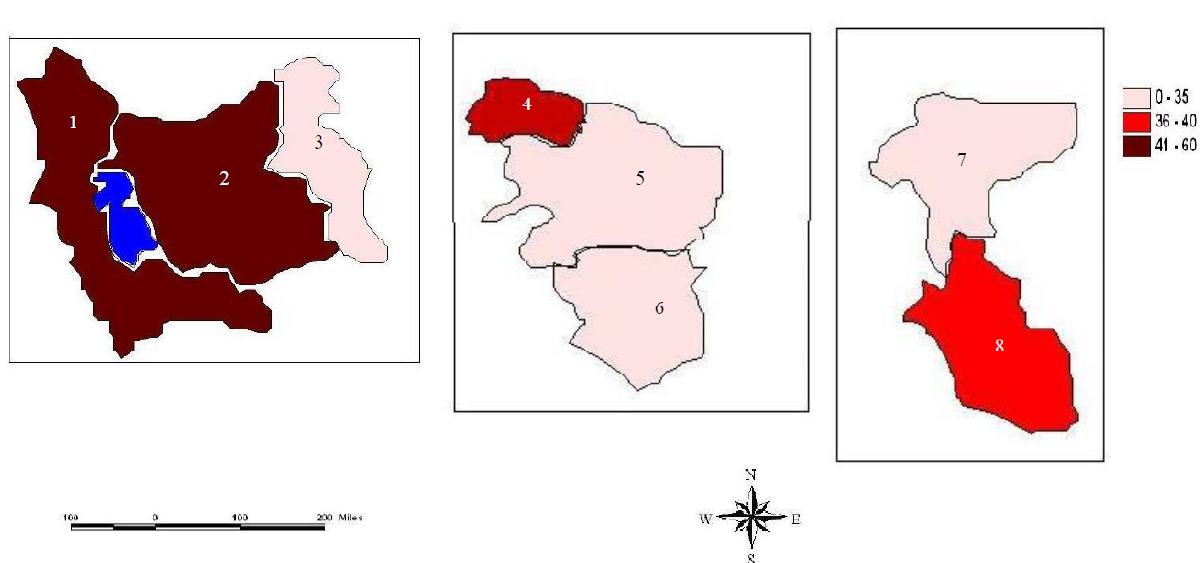
Fig. 5. Location rating based on all climate variables. 1-West Azerbaijan; 2-East Azerbaijan; 3-Ardabil; 4-north of Khorasan; 5-Raza- vi Khorasan; 6-south of Khorasan; 7-Isfahan;